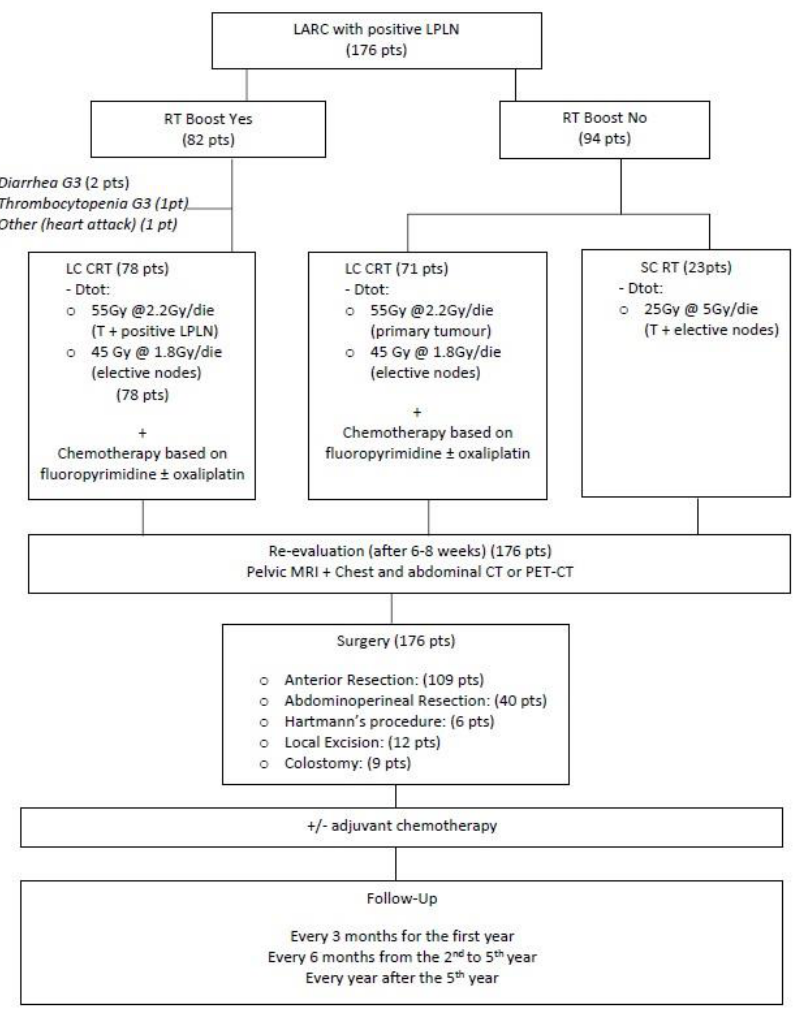
Figure 2. Flowchart of the clinical workflow. LARC: Locally Advanced Rectal Cancer; LPLN: Lateral Pelvic Lymph Nodes; RT boost yes/no: Radiotherapy boost yes/no; LC CRT: Long Course chemoradiotherapy; SC CRT: Short Course